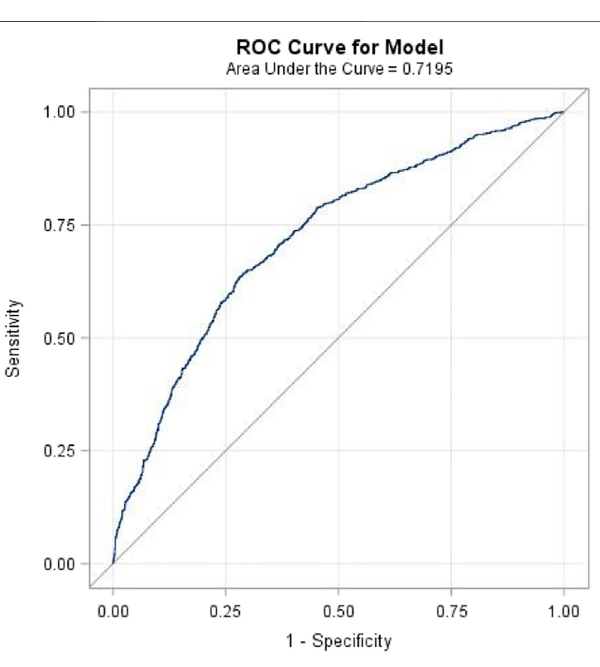
Frontiers in Pharmacology |